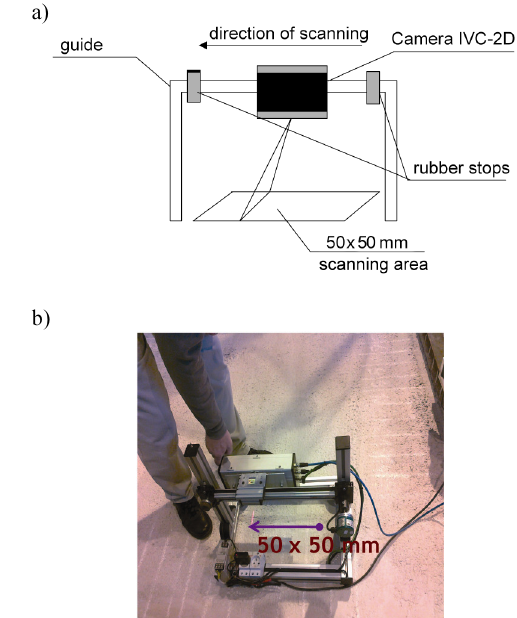
Fig. 4. Schematic of rig for investigating roughness of base layer surface by optical technique using optical camera (a) and actual testing (b) As described in Sadowski and Hoła (2013), the in- vestigations of the base layer surface were carried out in the previously marked grid points, by means of 1028×768 pixel resolution camera mounted on a guide. The portable computer. The camera with its lens by default ° fixed at an angle of 53 , was manually shifted on the guide.